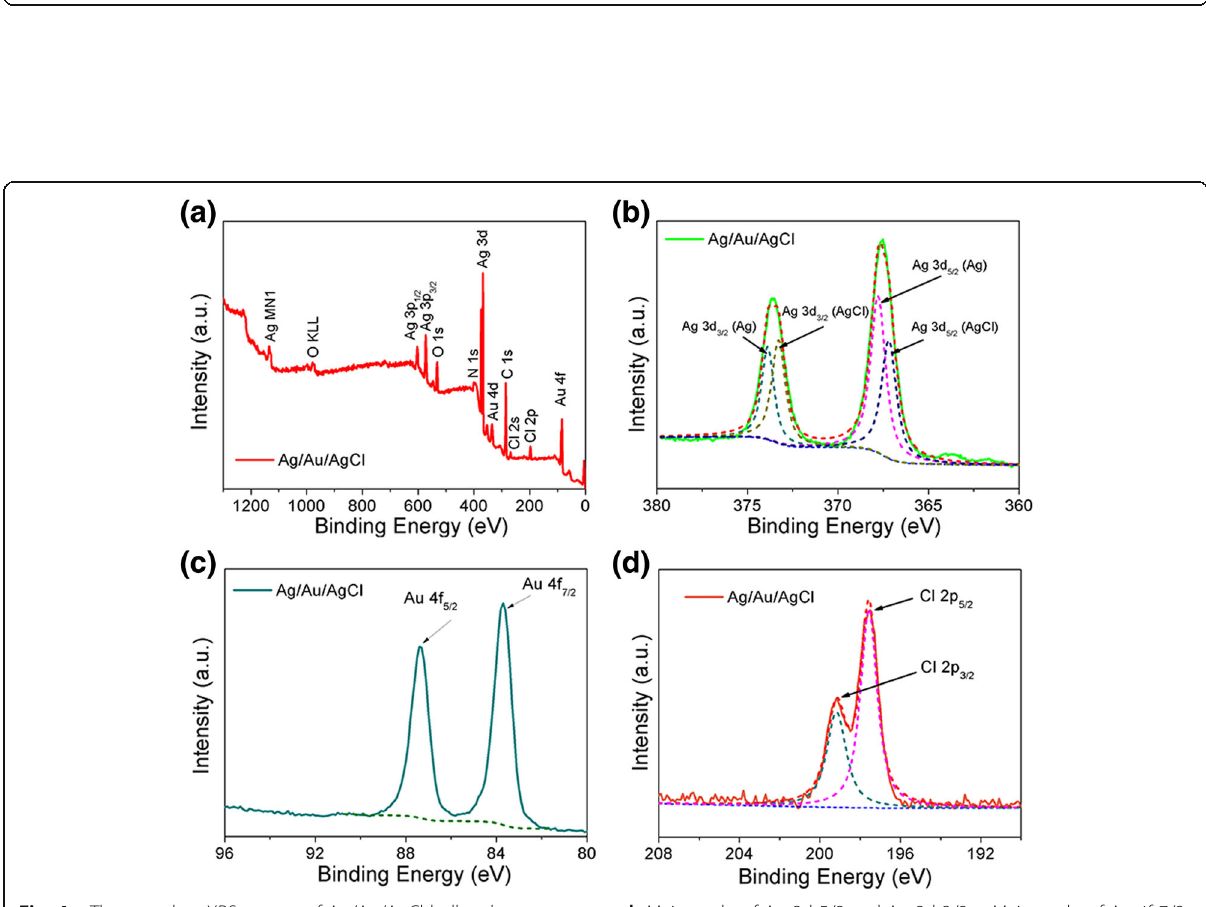
Fig. 4 a The complete XPS spectra of Ag/Au/AgCl hollow heterostructures. b Main peaks of Ag 3d 5/2 and Ag 3d 3/2. c Main peaks of Au 4f 7/2 and Au 4f 5/2. d Main peaks of Ag 2p 5/2 and Ag 2p